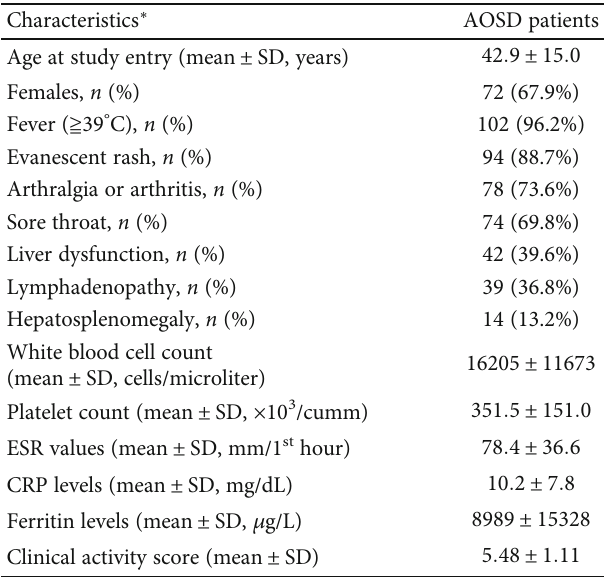
Table 1: Demographic data, clinical characteristics, and laboratory fi ndings of 106 patients with adult-onset Still ’ s disease (AOSD). Characteristics